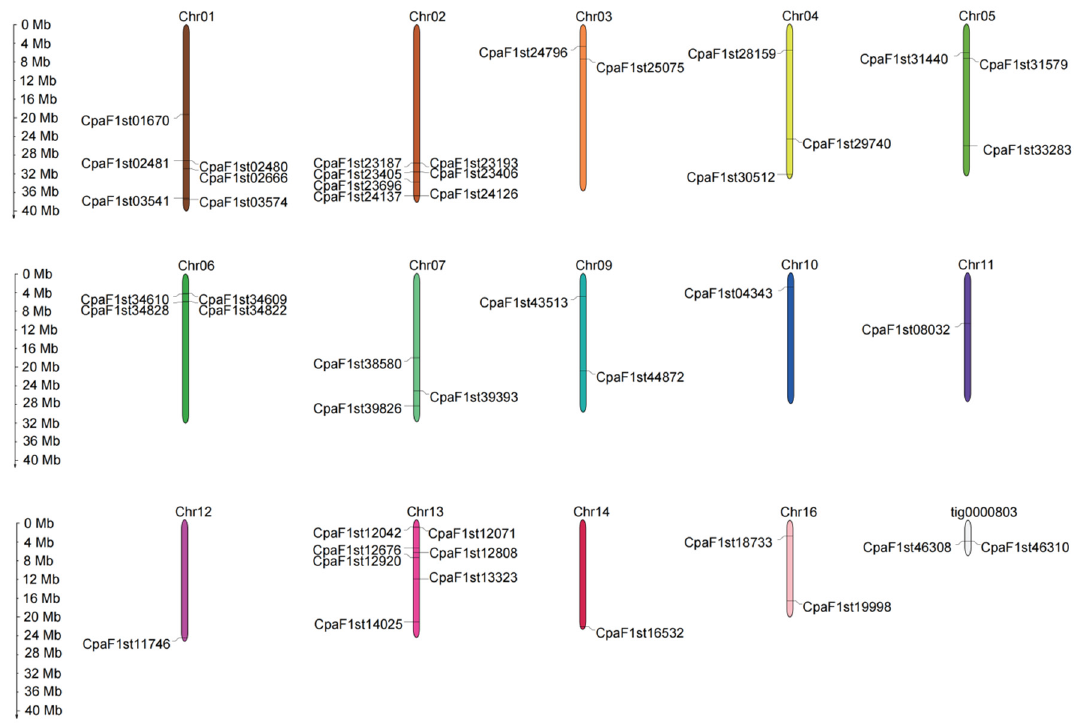
Figure 1. Chromosome distribution of MIKC-type MADS-box genes. C. paliurus chromosome number is indicated at the base of each chromosome with different colors. The MADS-box genes are marked at the approximate position on the chromosomes.